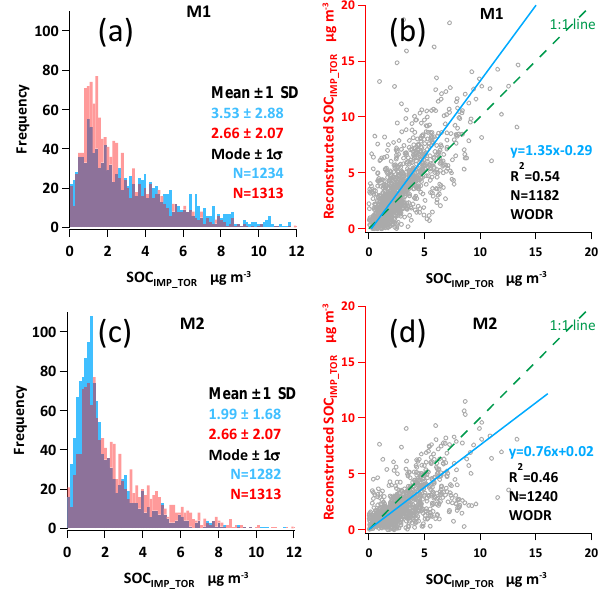
Figure 11. Histogram comparison of original SOC IMP_TOR (in red) with SOC IMP_TOR (in blue) reconstructed by M1 (a) and by M2 (c) . Scatterplot comparison of original SOC IMP_TOR (in x axis) with SOC IMP_TOR (in y axis) reconstructed by M1 (b) and by M2 (d)